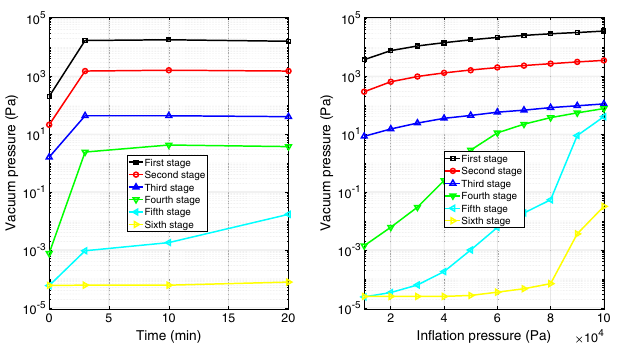
FIG. 19. Vacuum test results for Helium gas in VDS. (Left is for a long-term test: vacuum pressure in the plenum chamber stays at 5 × 10 4 Pa; Right is for the limit test: vacuum pressure in the plenum chamber varies from 1 × 10 4 Pa to 1 × 10 5 Pa gradually; the six lines from top to bottom: the first to the sixth stage of VDS).